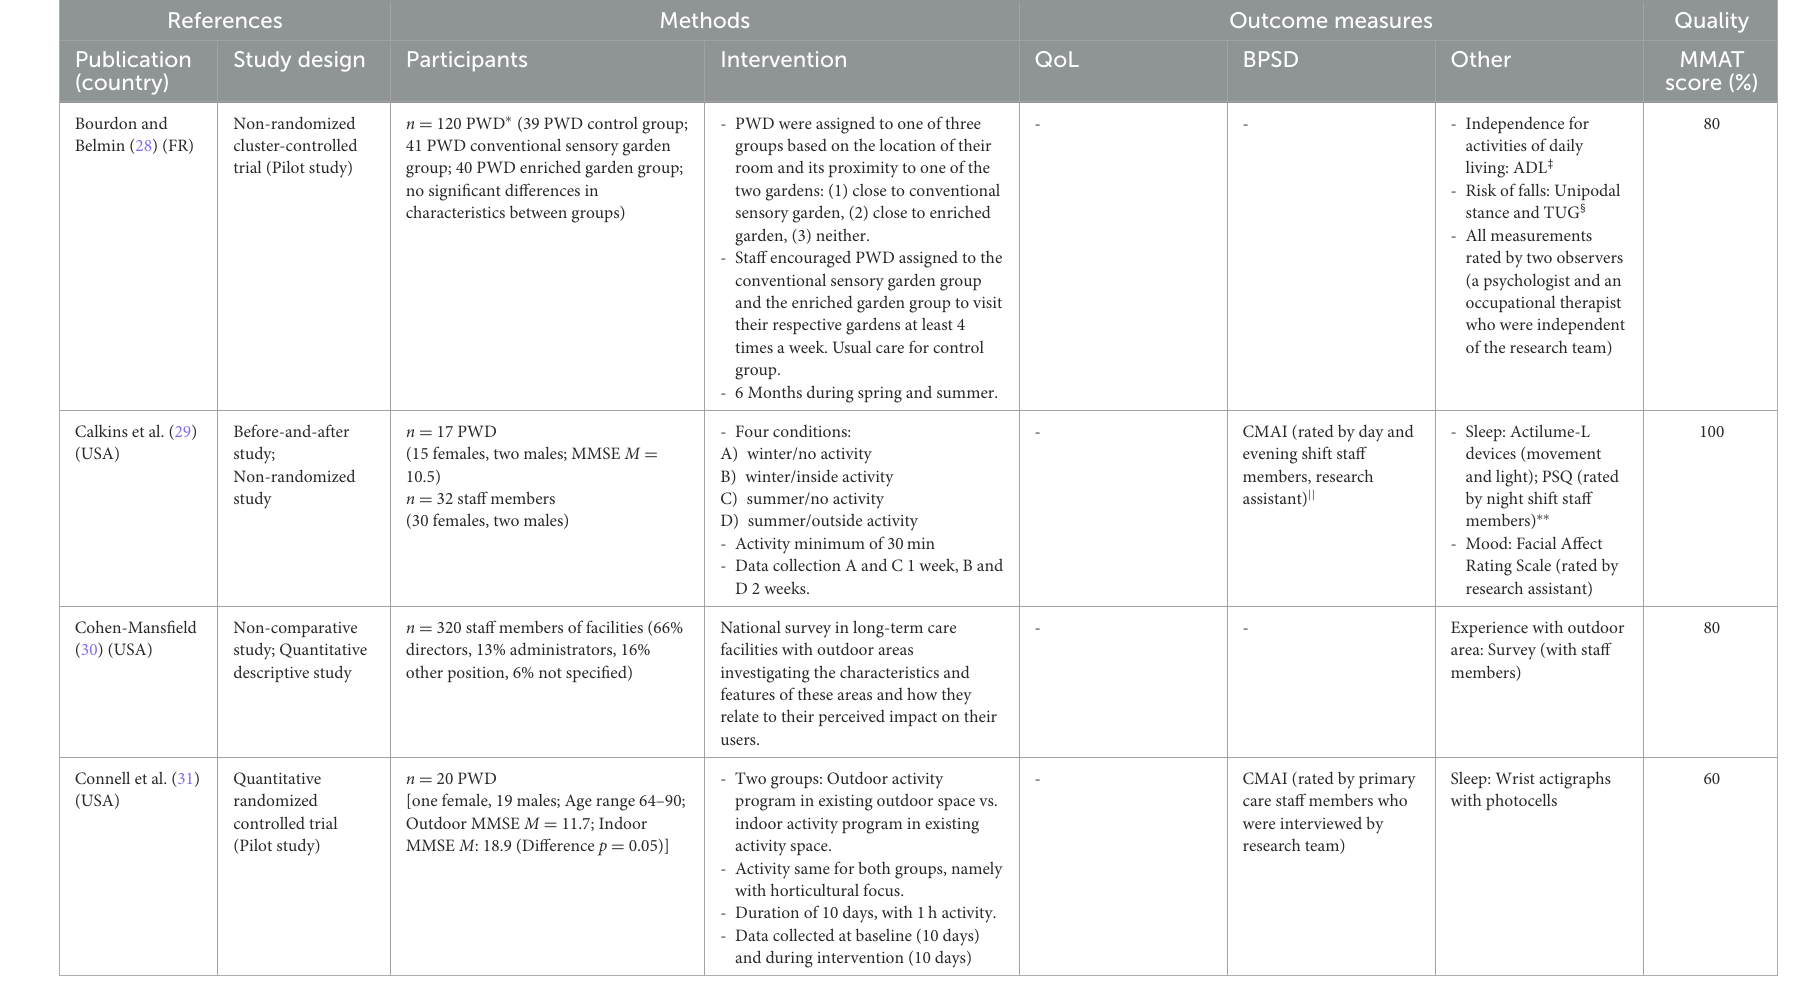
TABLE 1 Description of included publications ( N =